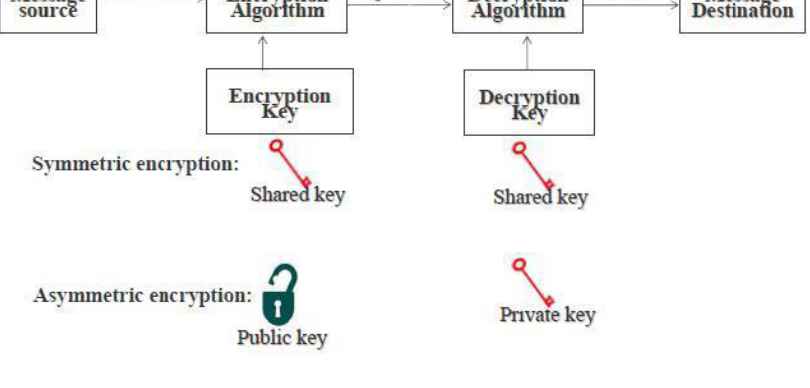
Fig. 4. Cryptographic